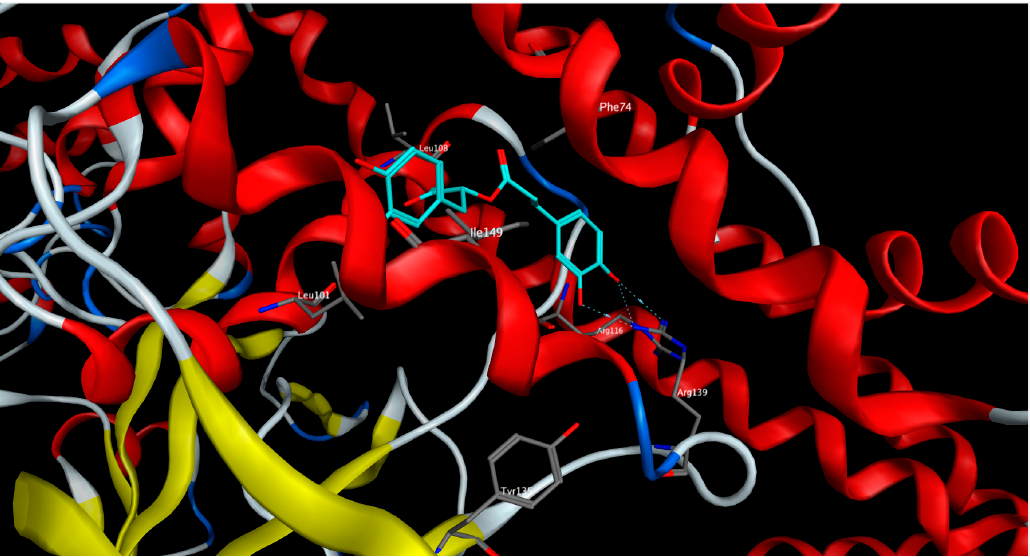
Figure 7. 3D-interactions of rosmarinic acid upon docking into the activators binding site in sGC- inactivated receptor state.